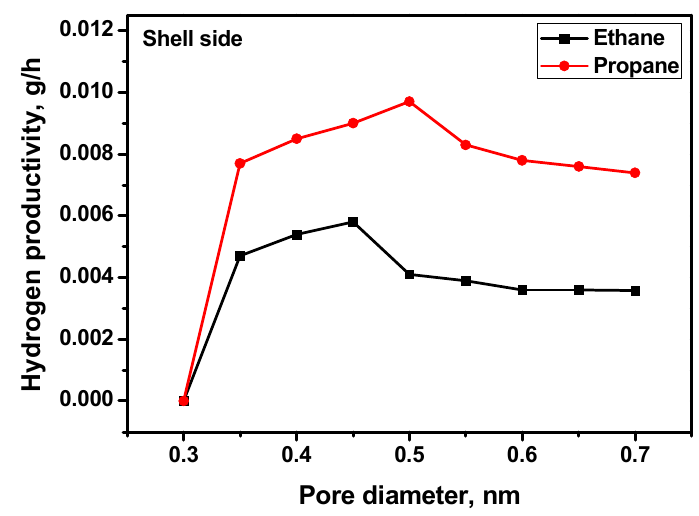
Figure 6. Hydrogen productivity vs. the membrane pore diameter.